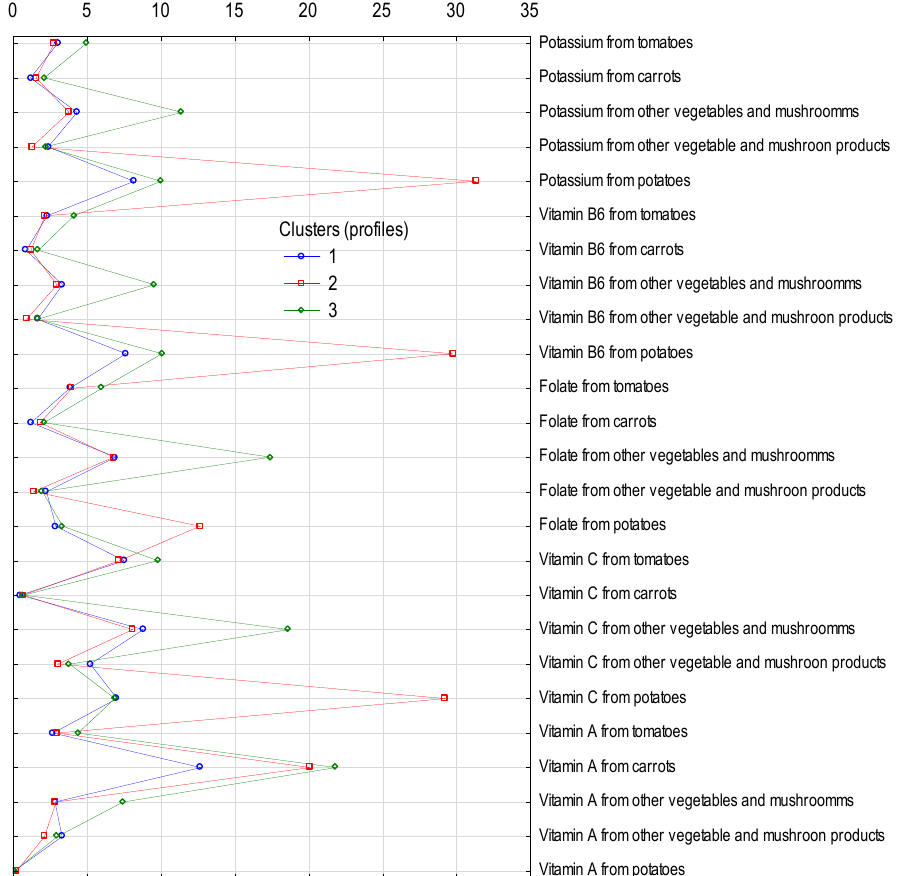
Figure 1. Cluster analysis: percentage contribution of selected nutrients from vegetables, potatoes, and their products.